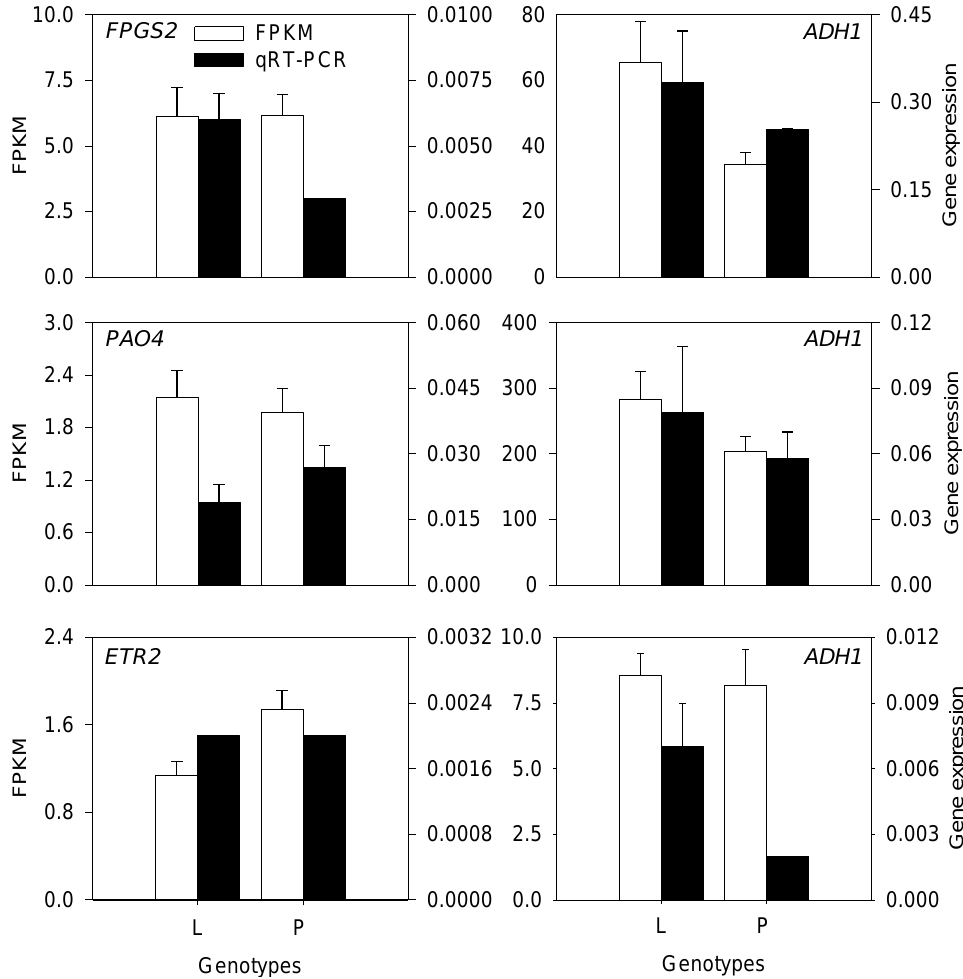
Figure 7. Validation of the mRNA expression levels of a gene by RNA-seq and qRT–PCR analyses.